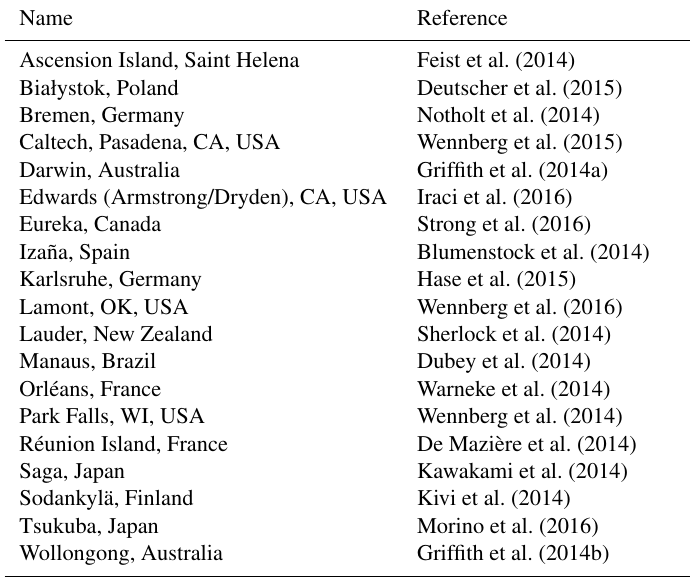
Table 2. Names of the TCCON stations used in this